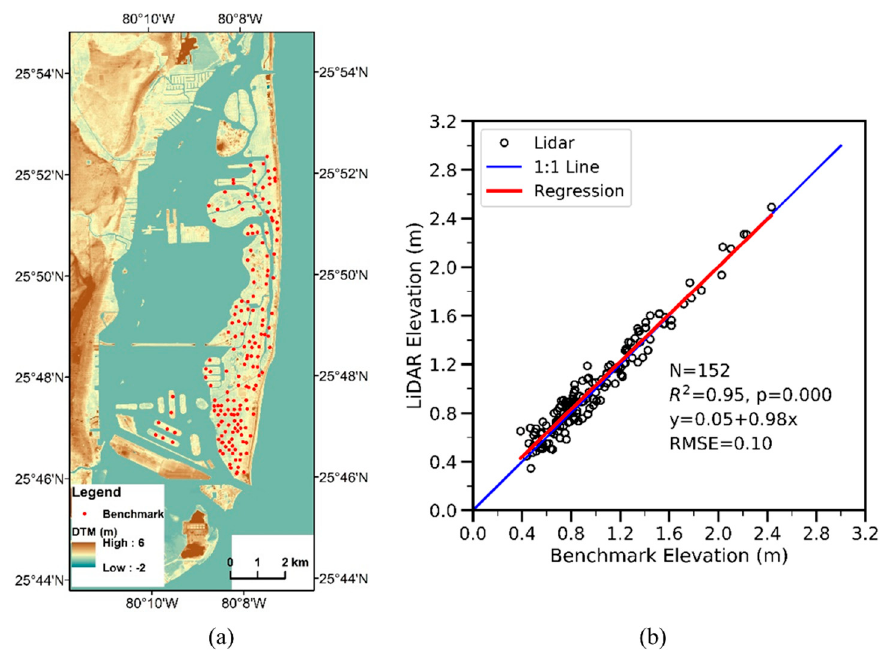
Figure 4. (a) The GPS benchmarks in the City of Miami Beach and (b) the linear regression between Figure 4. ( a ) The GPS benchmarks in the City of Miami Beach and ( b ) the linear regression between GPS benchmarks and LIDAR DTM elevations. GPS benchmark and LiDAR DTM